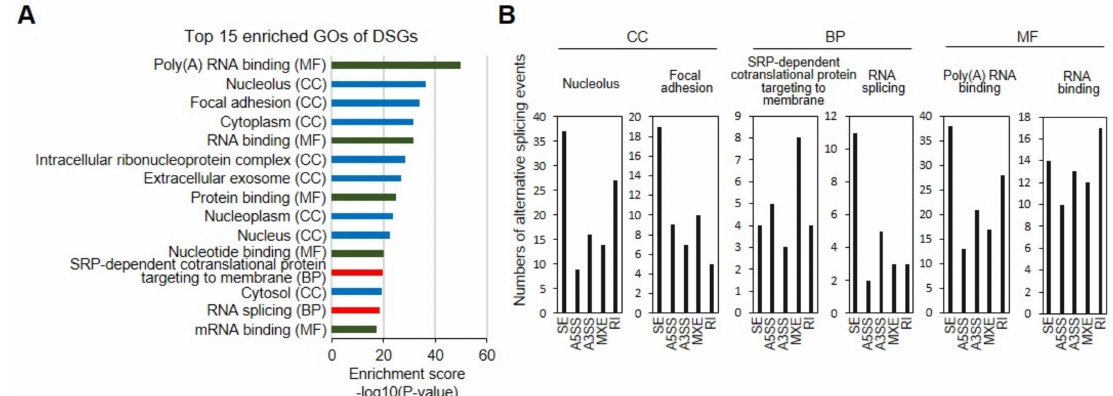
Figure 3. Comparative GO analysis of genes with AS events between iMSCs and UCB-MSCs. ( A ) Top 15 GO terms of genes with AS events. The bar chart showing 15 GO terms significantly enriched in iMSCs. The x-axis indicates the enrichment scores [ − log10 ( p value), p -value cut-off of 0.05] for each GO term. The y-axis represents each detailed classification of GO terms. ( B ) The numbers of the five types of AS events for each indicated GO